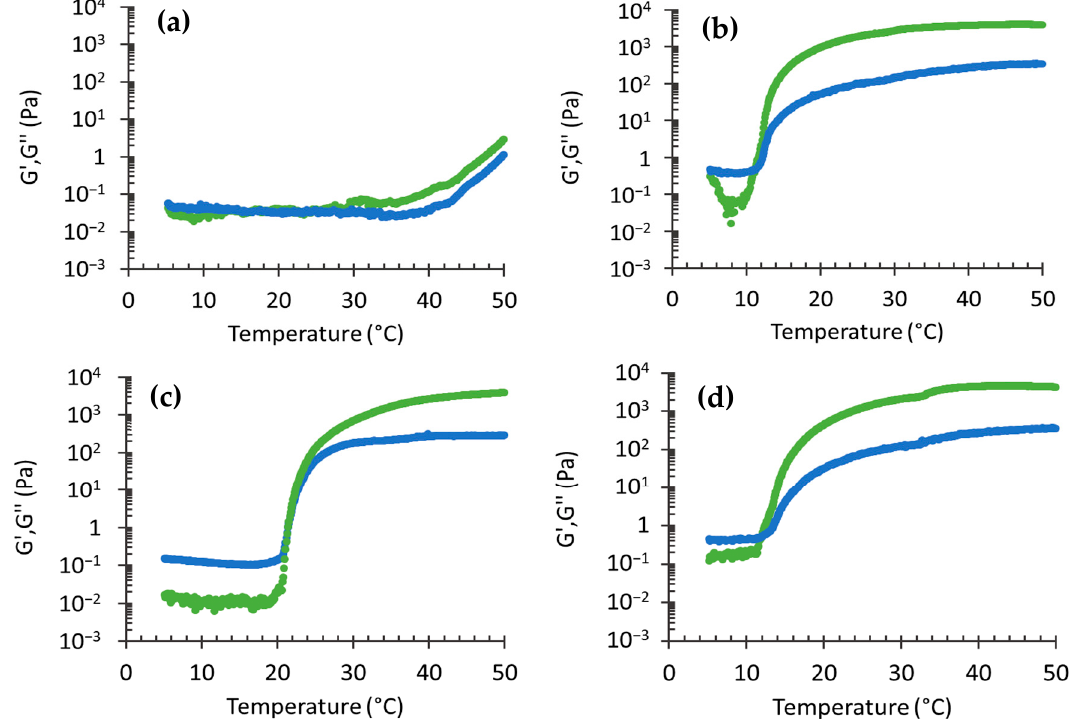
Figure 5. E ff ect of the temperature on storage (G’, green) and loss (G”, blue) moduli for ETHO ( a ), Figure 5. Effect of the temperature on storage (G’, green) and loss (G’’, blue) moduli for ETHO ( a ), ETHO-pol ( b ), CA-pol ( c ), and CA-ETHO-pol ( d ETHO-pol ( b ), CA-pol ( c ), and CA-ETHO-pol ( d ).